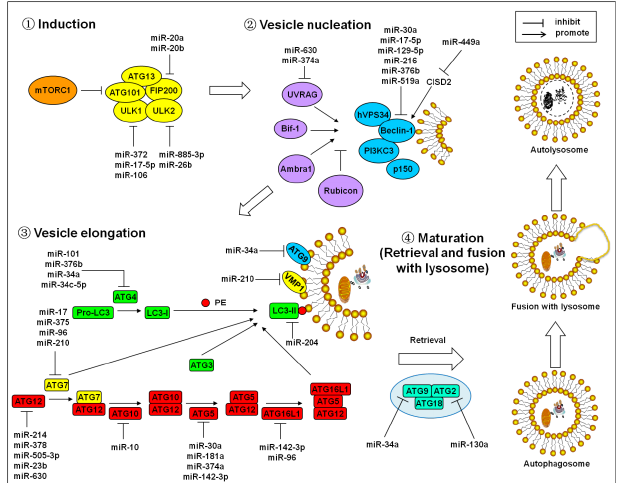
Figure 1. MicroRNAs regulate the core autophagy signaling cascades. Autophagy proceeds in four successive stages including induction, vesicle nucleation, vesicle elongation, and maturation. MicroRNAs are implicated in the processes. See text for detailed explanations. Arrows represent the promotion effect. T bars represent the inhibition effect.